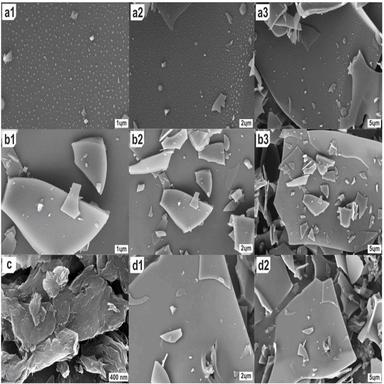
SEM images of samples (a1, a2, a3: Expanded raw perlite; b1, b2, b3: Acid-treated perlite; c: Graphen oxide; d1, d2: Perlite@GO).